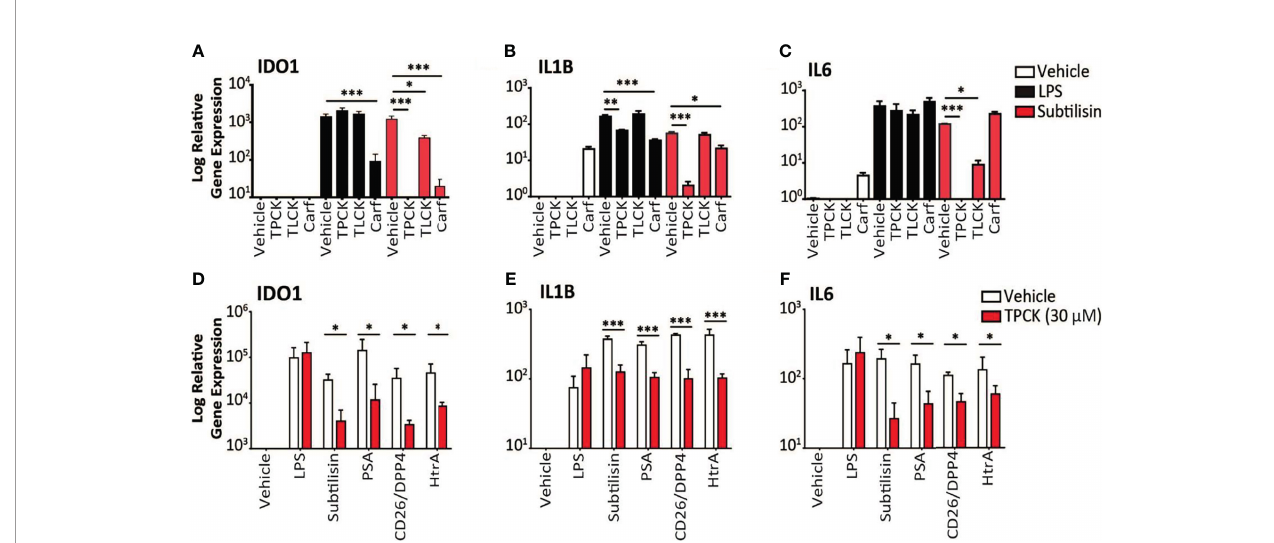
FIGURE 3 | Inhibition of serine protease activity. (A – C) The charts illustrate the expression relative to baseline (logarithmic scale) of (A) IDO1 , (B) IL1B , (C) IL6 and the effects of vehicle (open bars), 10 ng/mL LPS (black bars) or 20 nM subtilisin (red/shaded bars). The inhibitors tested were TPCK (100 m M), TLCK (100 m M) and car fi lzomib 20 nM (Carf). (D – F) The charts show a comparison of the effects of TPCK (30 m M) on the induction of IDO1 (D) , IL1B (E) and IL6 (F) by LPS (10 ng/mL), subtilisin (20 nM), PSA (100 nM), CD26/DPP4 (10 nM) and HtrA (10 nM). Expression is shown for vehicle (open bars) and TPCK (30 m M) (red/shaded bars) treatments. Charts show the mean ± s.e.m. (n ≧ 3 donors). *P < 0.05, **P < 0.01; ***P <